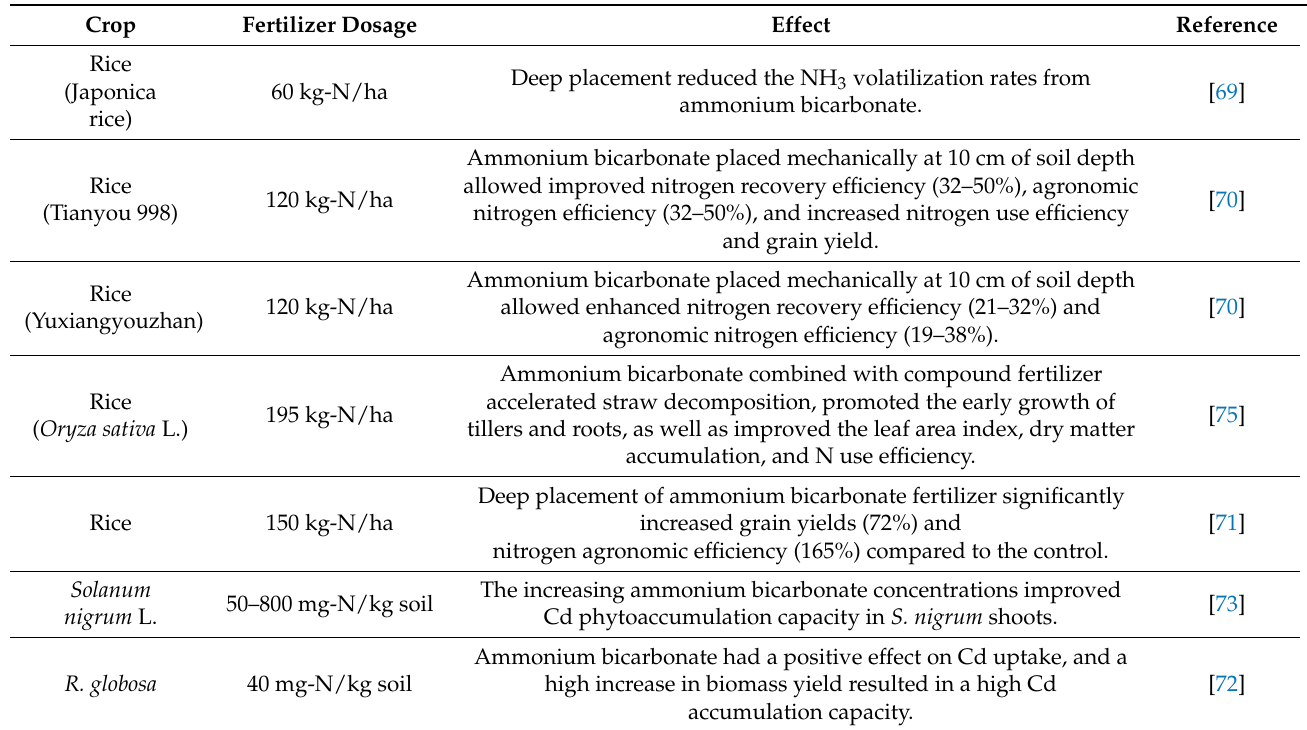
Table 3. The main crops, fertilizer doses, and effects observed from ammonium bicarbonate applica- tion as